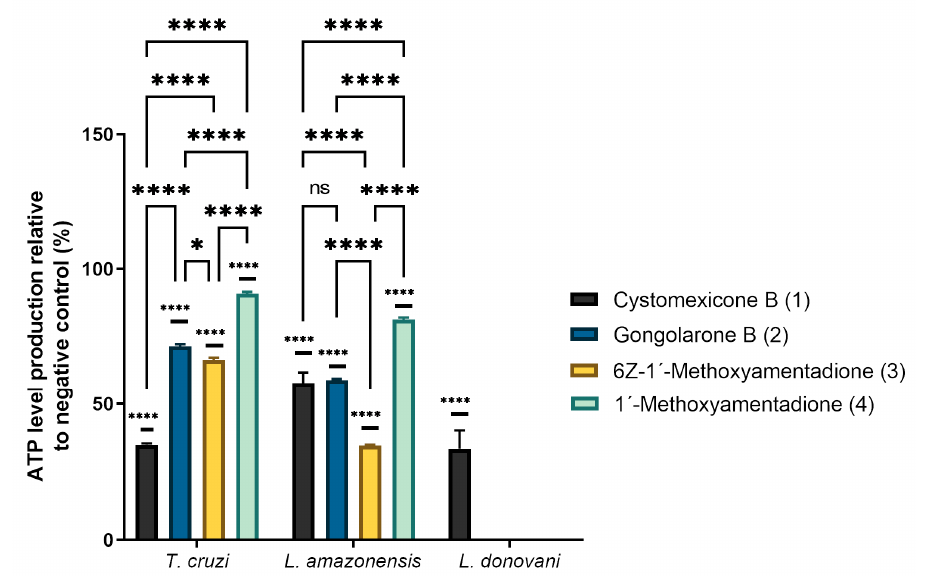
Figure 3. Percentages of ATP levels relative to negative control. The analysis of variance was determined by one-way ANOVA using GraphPad.PRISM ® 9.0 software. Significance differences when comparing different percentages values are represented as ns = non-significant; * p < 0.1 and **** p < 0.0001.